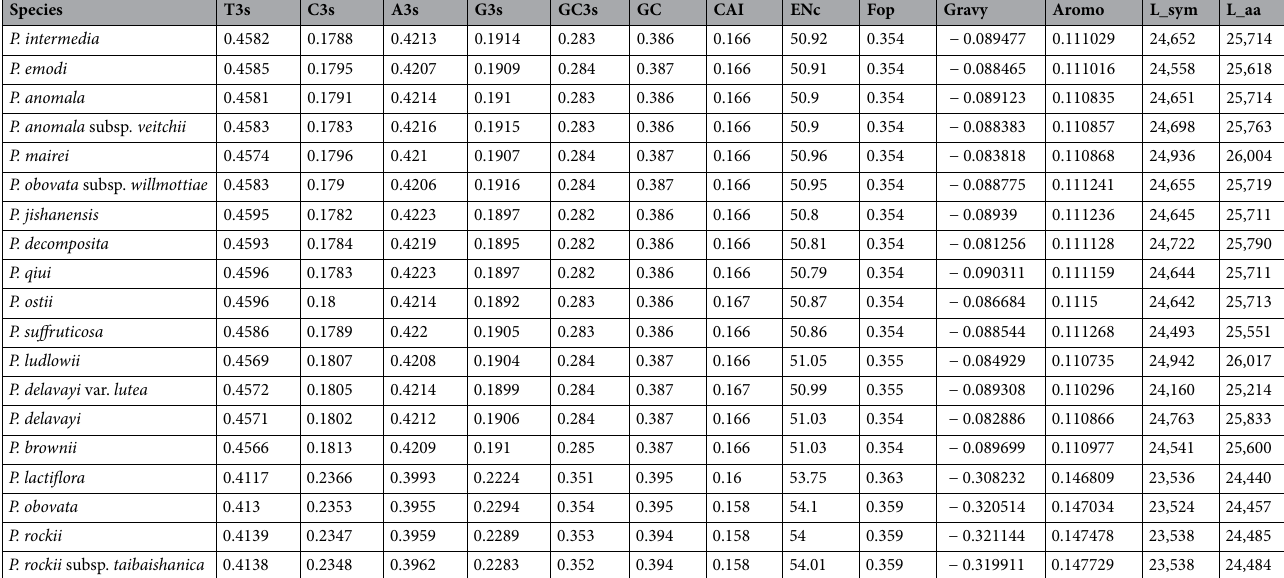
Table 1. Codon usage of the Paeoniaceae species. T3s/C3s/A3s/G3s/GC3s the thymine/cytosine/adenine/ guanine/GC content at synonymous third codon position, GC the total GC content, CAI codon adaptation index, ENc effective number of codons, Fop Frequency of optimal codons, Gravy the influence of protein hydrophobicity on codon usage bias, Aromo the influence of aromatic protein on codon usage bias, L_sym number of synonymous codons, L_aa total number of synonymous and non-synonymous